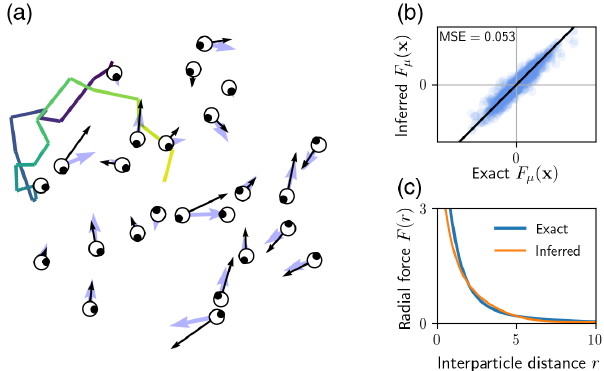
FIG. 7. Stochastic force inference for harmonically trapped active Brownian particles with soft repulsive interactions F ð r Þ ¼ 1 = ð 1 þ r 2 Þ between particles at distance r . (a) Snapshot of a configuration for 25 active particles. The black dots indicate the direction of self-propulsion. We perform SFI on a trajectory of only 25 frames blurred to mimic measurement noise. Background shows the trajectory of one particle and force on each particle, inferred (blue arrows) and exact (black arrows). The fitting basis for SFI consists of a combination of harmonic trapping, constant- velocity self-propulsion, and radial interactions between particles with the form r k e − r=r 0 with k ¼ 0 ; … ; 5 and r 0 a typical nearest- neighbor distance between particles. (b) Inferred versus exact components of the force on all particles along the trajectory. (c) Inferred radial force between interacting particles, compared to the exact